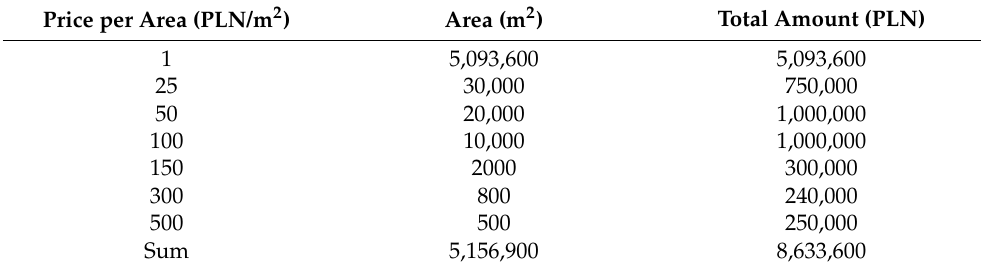
Figure 5. Map presenting the estimation of the material and environmental losses [36]. Table 8. Generating the material losses for the Bra ń szczyk commune.